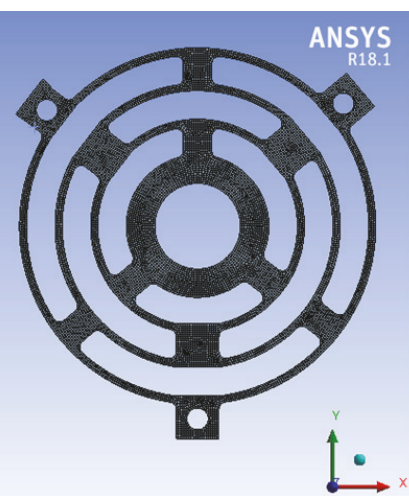
Figure 2: Meshing model for the flexure elbow joint.